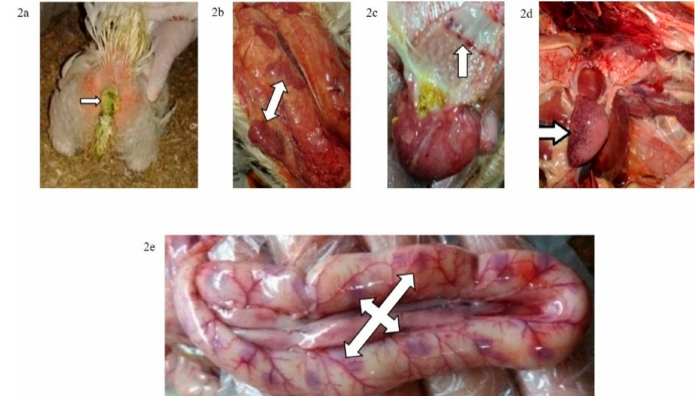
Figure 2. ( a ) Greenish diarrhoea in a broiler chickens infected IM with NDV-VIId (G1c); ( b ) congestion in the thymus of a broiler chicken in G1c; ( c ) petechial haemorrhage at the junction between the oesophagus and proventriculus of a broiler chicken in G1c; ( d ): button-like ulcer in the intestine of a